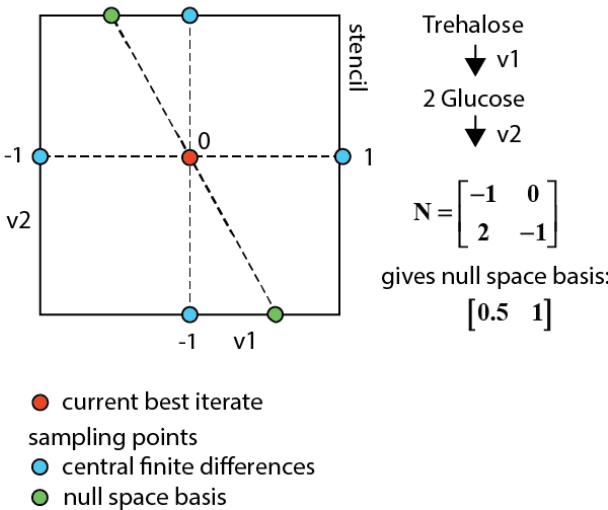
Figure 8. Sampling space for a network with two fluxes and one measured metabolite (glucose). When using central finite differences the blue points are sampled. Using the